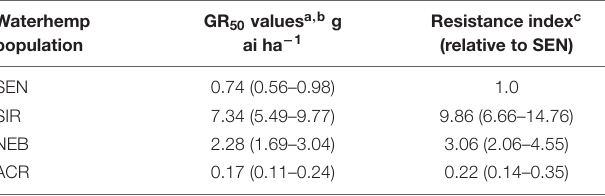
a Data were calculated based on the dose-response curves depicted in Figure 2 . b Confidence limits at 95% are listed in parentheses next to each GR 50 value. c Resistance indices are based on the ratio of the GR 50 value for each population relative to SEN.